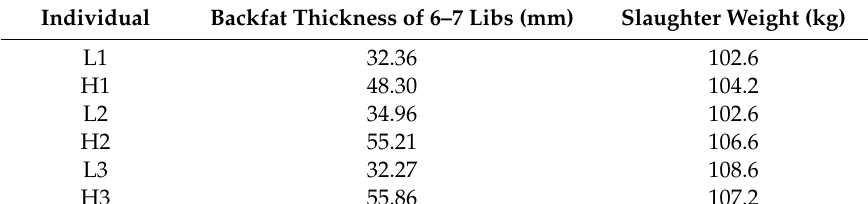
Table 1. Phenotype information of three full-sibling pigs.